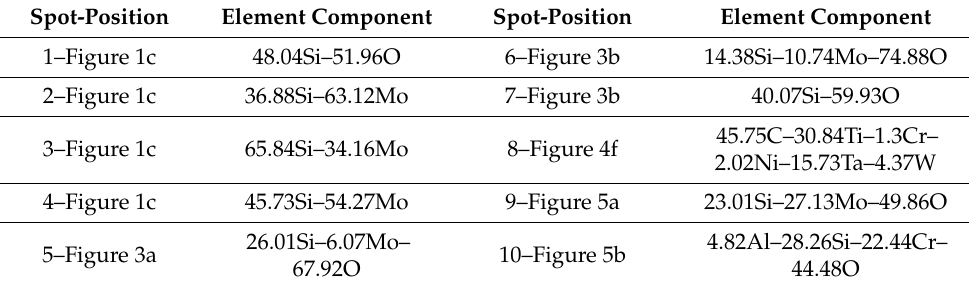
Table 2. The detected points measured by EDS—Atom percent (at %). Spot-Position